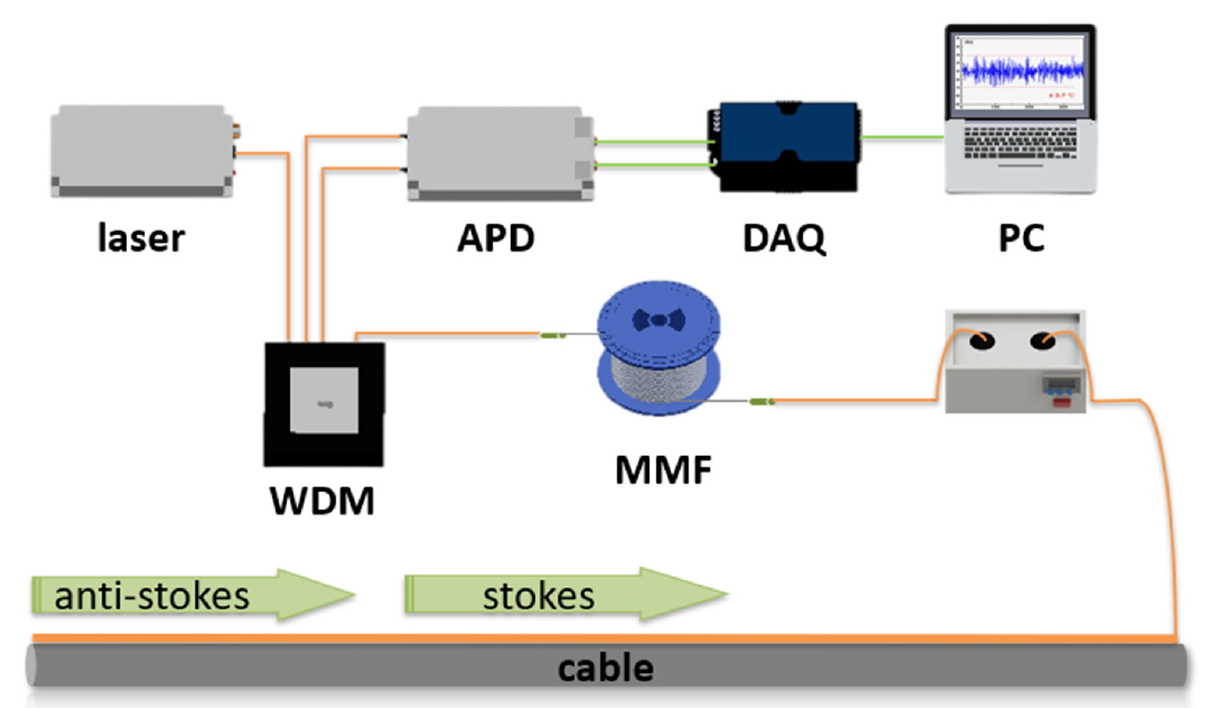
Figure 7. The experimental setup of the RDTS